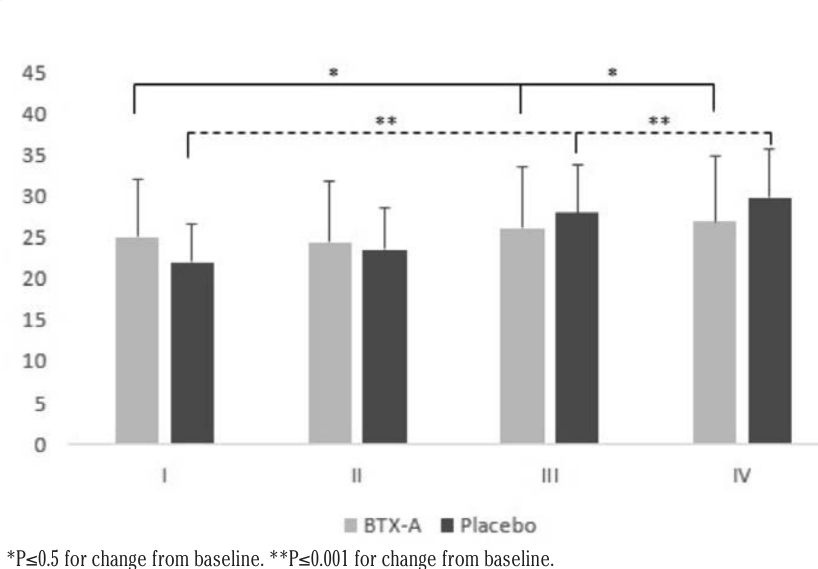
*P ≤ 0.5 for change from baseline. **P ≤ 0.001 for change from Figure 2. Changes during the follow-up time in the Total score Fugl-Meyer Scale.